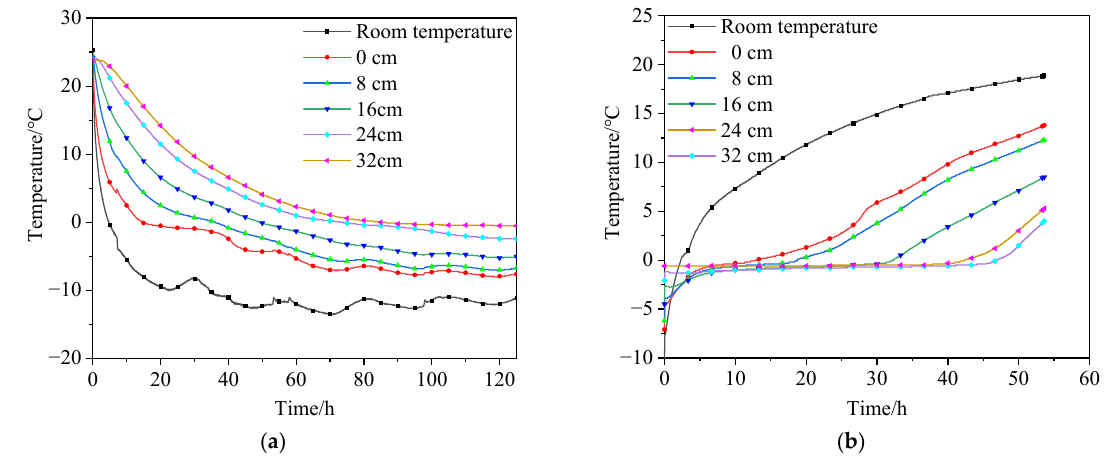
Figure 5. The temperature change curves during the freeze–thaw processes: ( a ) cooling; ( b ) heating.